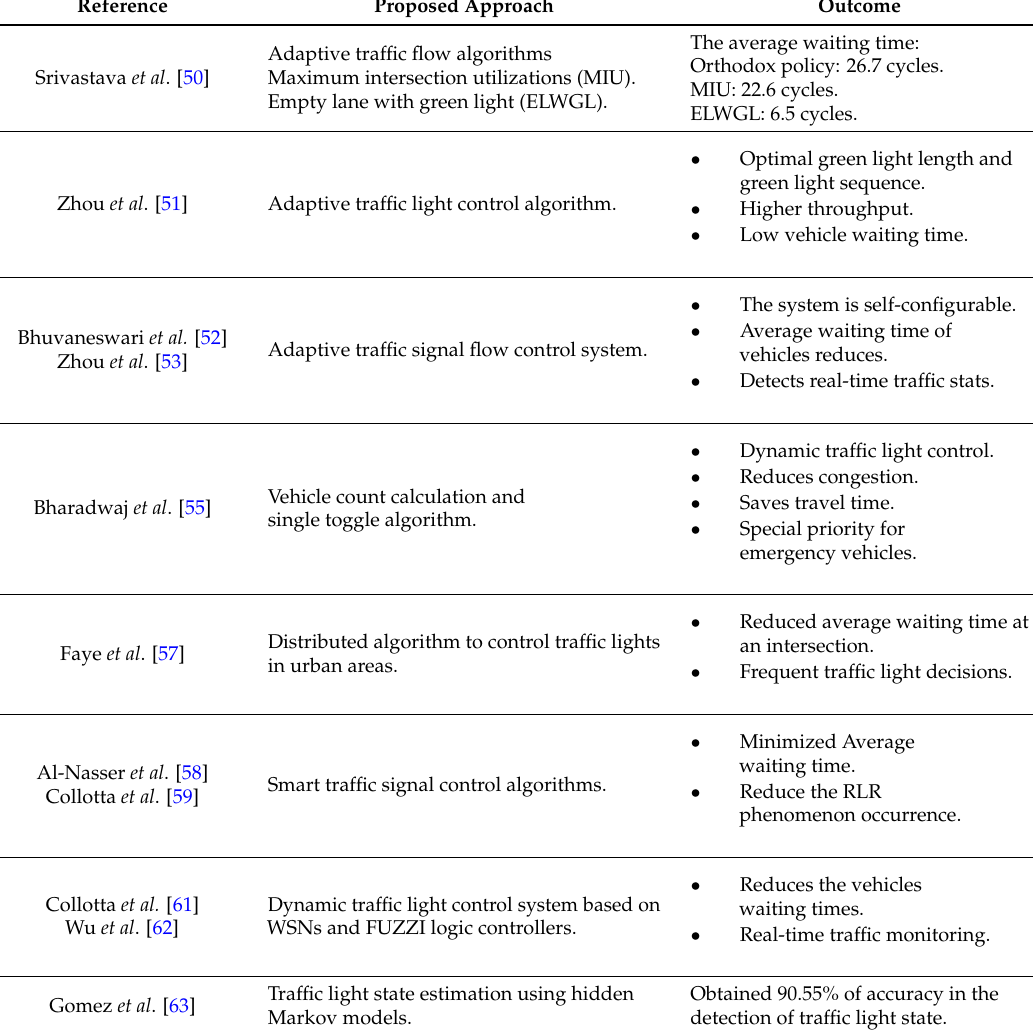
Table 8. Summary of average waiting time reduction